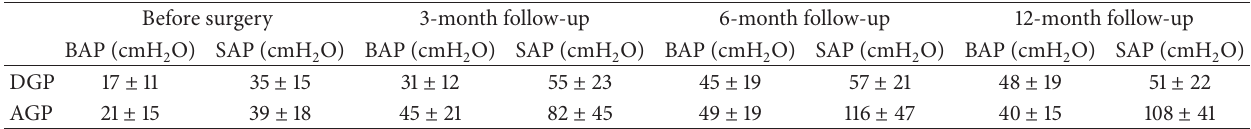
Table 1: Manometric examination results (BAP: basal anal pressure, SAP: squeeze anal